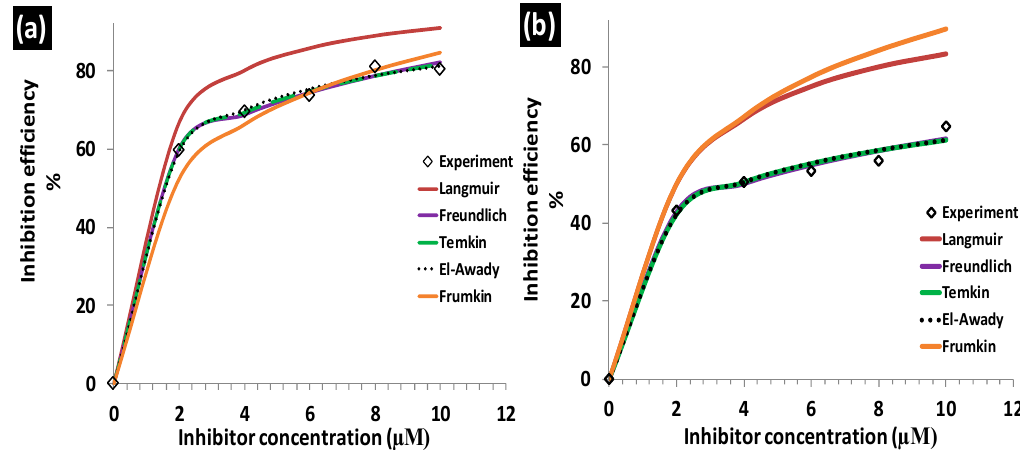
Figure 6. Comparison of experimental and theoretical inhibition efficiency values of ( a ) ClGaBTThioPc and ( b ) BTThio.